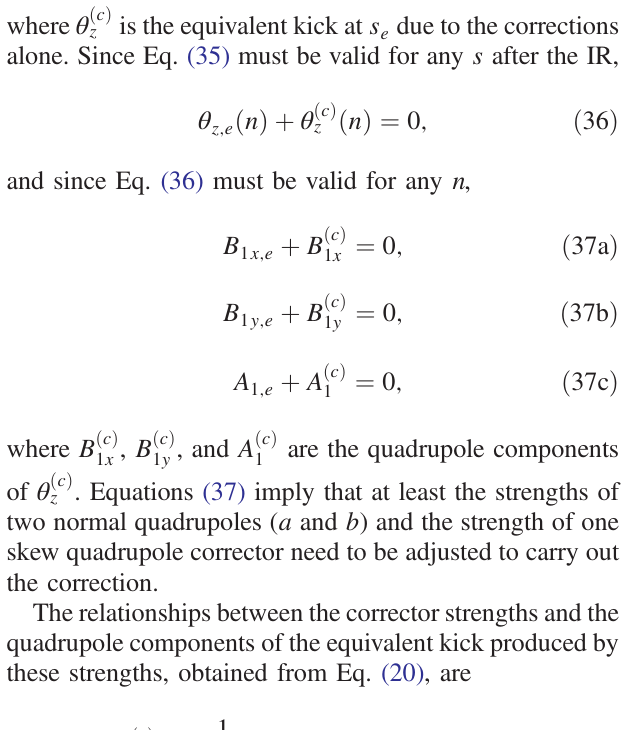
FIG. 4. Action plots of the average trajectories shown in Fig. 3. A significant reduction in fluctuations (noise) can be seen as more turns are used to build the average